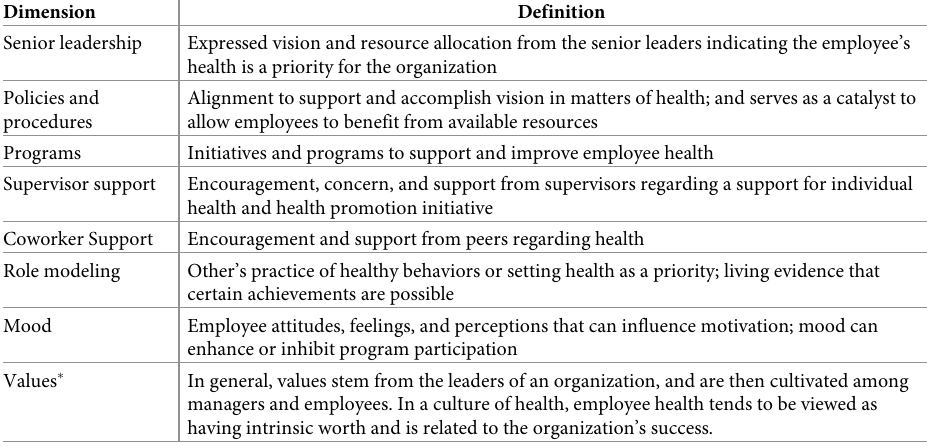
Table 1. Definitions of the culture of health dimensions